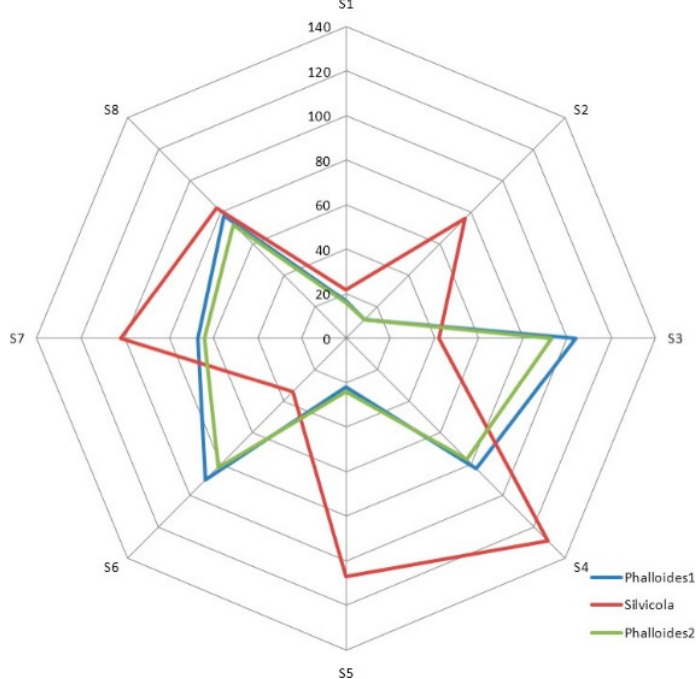
Figure 2. Radial plot of sensors